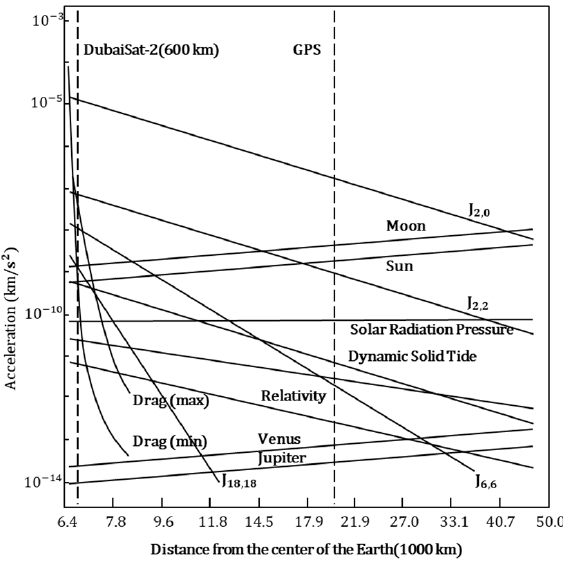
Figure 1. Order of magnitude of various perturbations of a satellite orbit. See text for further explanation [13].